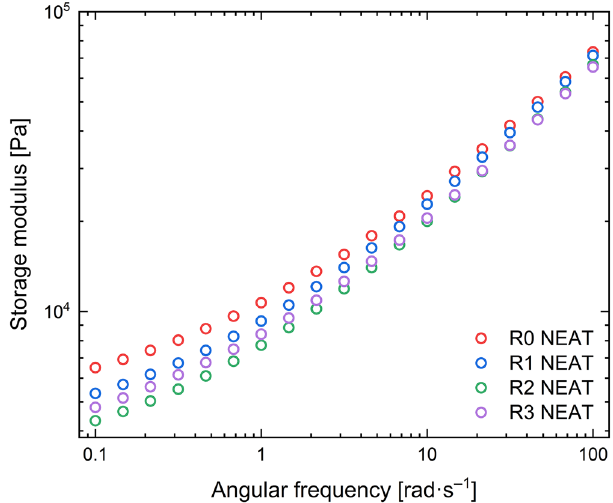
Figure 6. Dynamic frequency sweeps for the neat TPU samples at 150 °C.